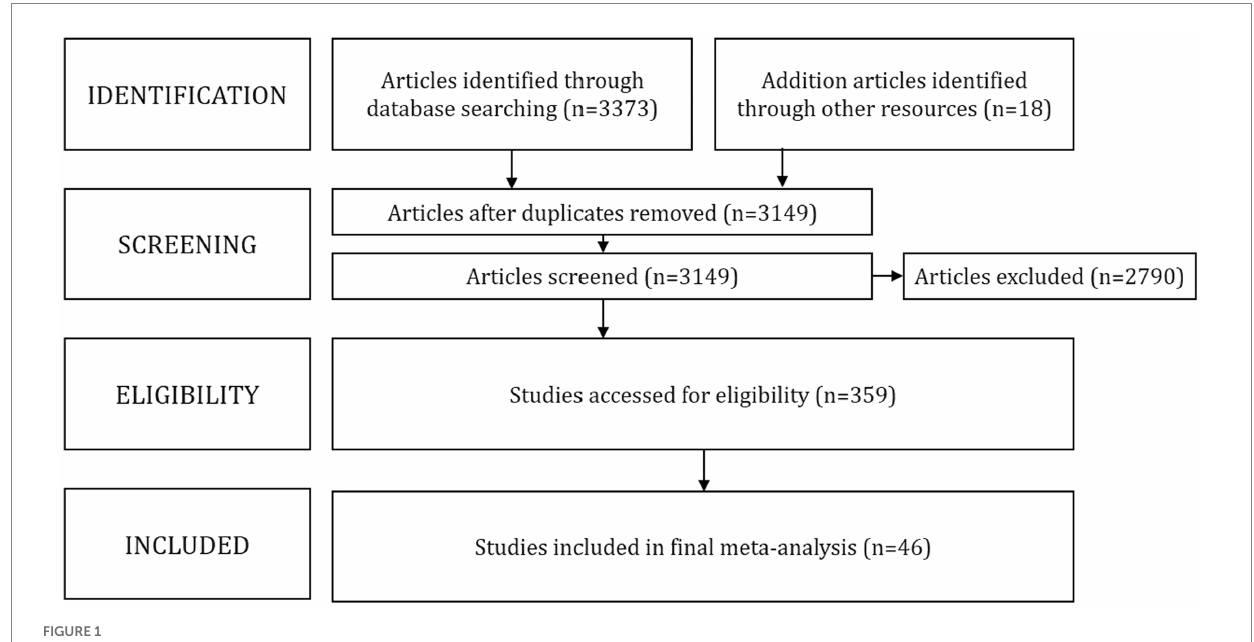
FIGURE 1 Literature selection